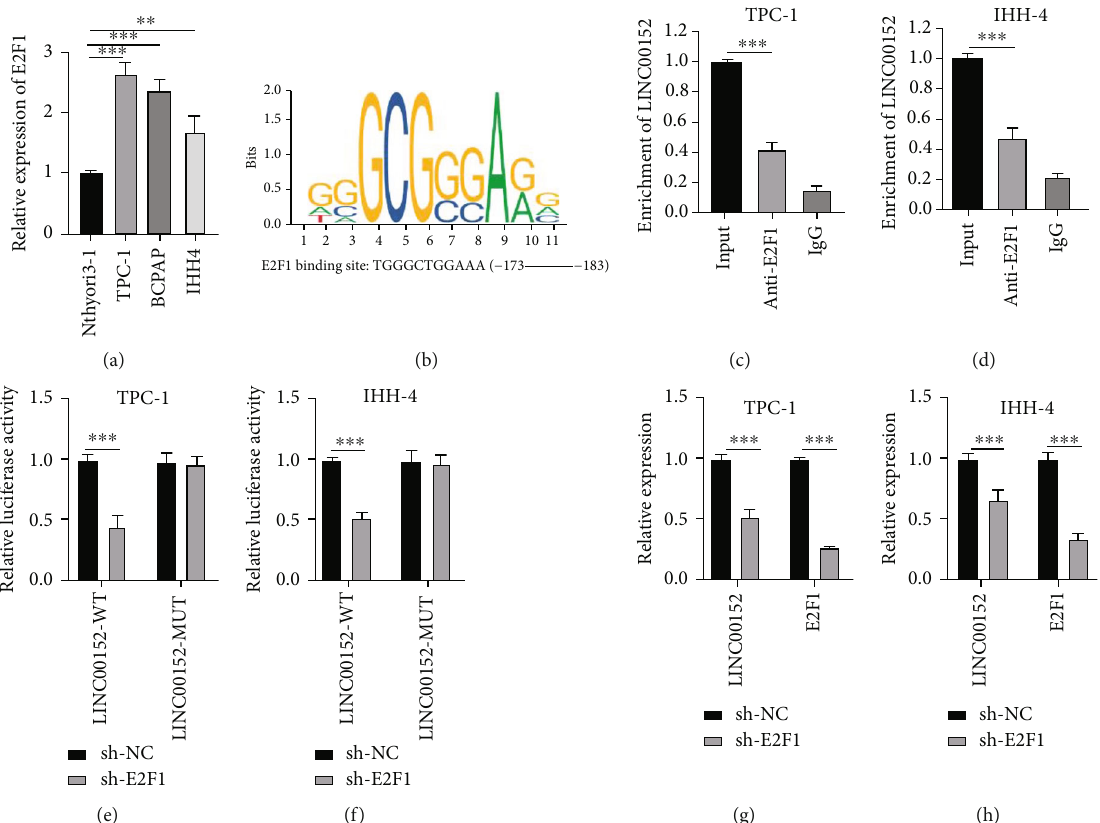
Figure 2: E2F1 induces the upregulation of LINC00152 expression. (a) E2F1 expression patterns in PTC cell lines measured by RT-qPCR. (b) Binding site between E2F1 and LINC00152 promoter predicted by JASPAR. (c, d) The interaction between E2F1 and LINC00152 in (c) TPC-1 and (d) IHH-4 cells veri fi ed by RIP. (e, f) The interaction between E2F1 and LINC00152 in (e) TPC-1 and (f) IHH-4 cells detected by dual-luciferase reporter gene assay. (g, h) Expression patterns of E2F1 and LINC00152 in (g) TPC-1 and (h) IHH-4 cells after silencing E2F1 assessed by RT-qPCR. Repetitions = 3 . Data are expressed as mean ± standard deviation . The t -test was used for pairwise comparison. One- way ANOVA was used to determine statistical signi fi cance. Tukey ’ s multiple comparisons test was applied for post hoc test. ∗∗ p < 0 : 01 ; ∗∗∗ p < 0 : 001